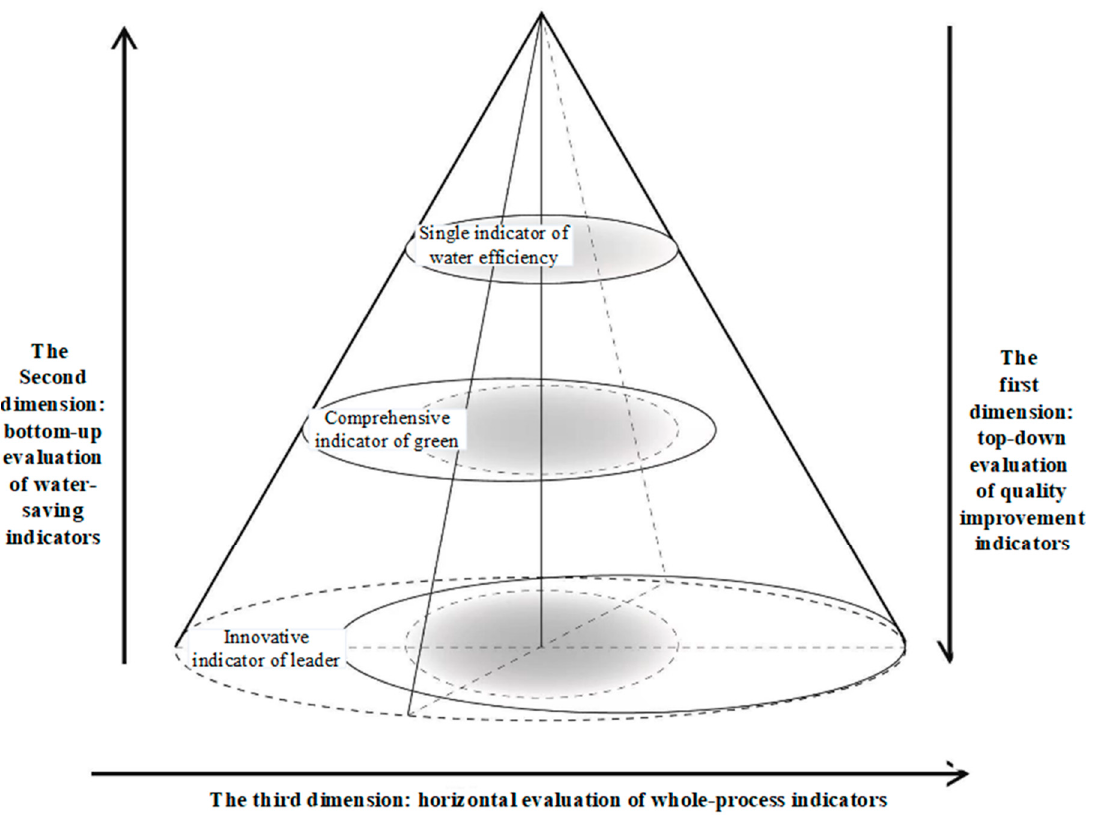
Figure 2. “3 + 3” performance evaluation system.